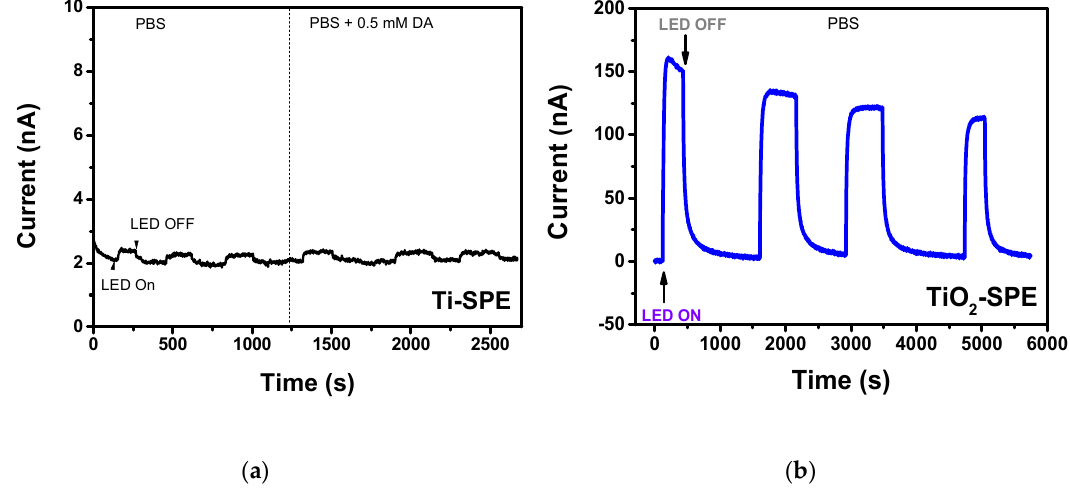
Figure 7. ( a ) Photocurrent signal of the bare Ti-SPE registered at V Ag/AgCl = 0 V under pulses of UV LED light (400 nm) in the absence of and in the presence of different concentrations of dopamine. ( b ) Photocurrent signal of the modified TiO 2 electrode in the same conditions in the absence of dopamine.